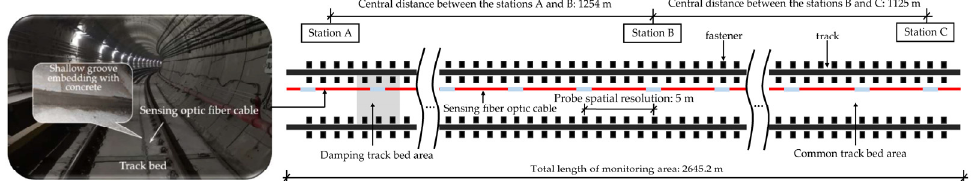
Figure 1. Field deployment of the ultra-weak FBG sensing array for acquiring vibration responses of track beds.